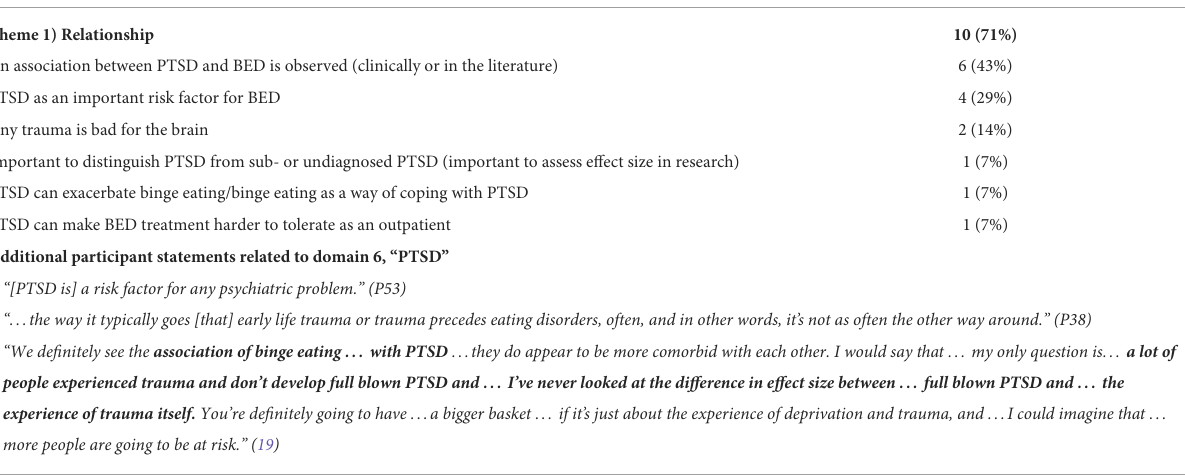
TABLE 9 Participant statements relating to domain 6,